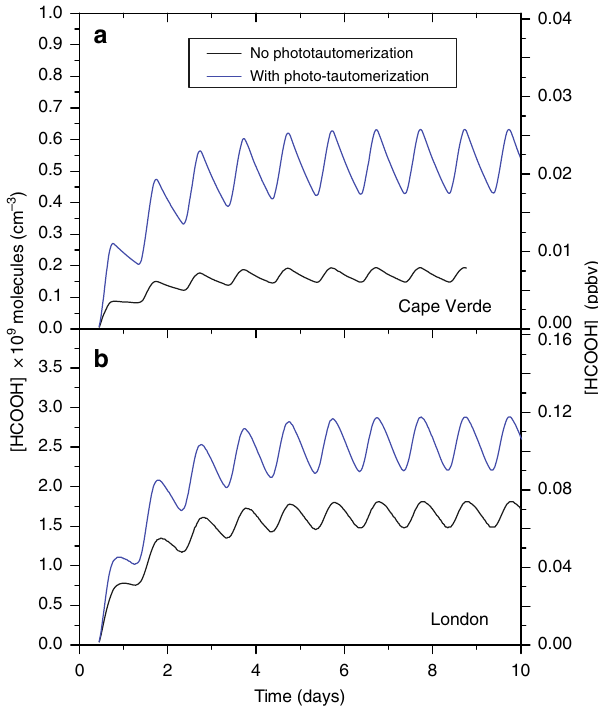
Fig. 4 Master Chemical Mechanism simulations. Master Chemical Mechanism box model simulations of formic acid production with (blue) and without (black) photo-tautomerization and OH + vinyl alcohol reactions. Two distinct atmospheric conditions are shown: a pristine, ocean environment at Cape Verde, Sao Vincente Island, and b urban environment